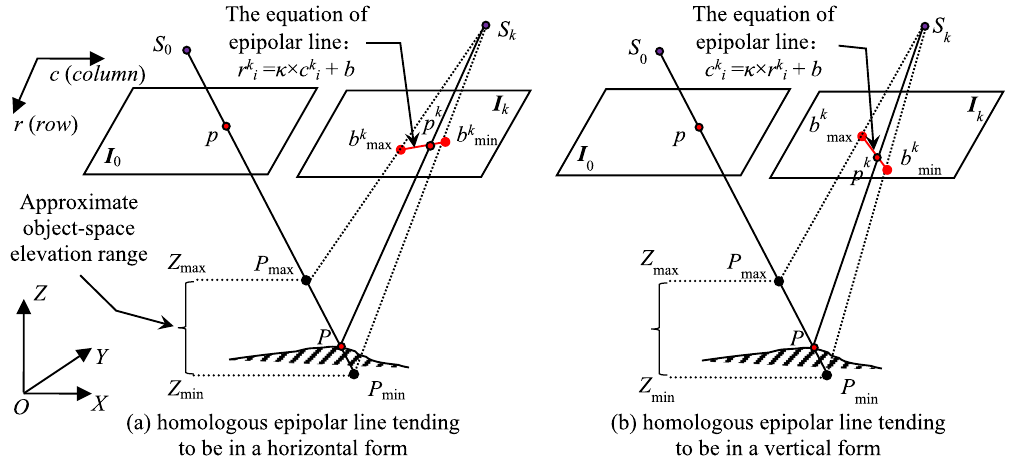
Figure 4. The sketch of determining candidate homologous pixels based on the object-space elevation